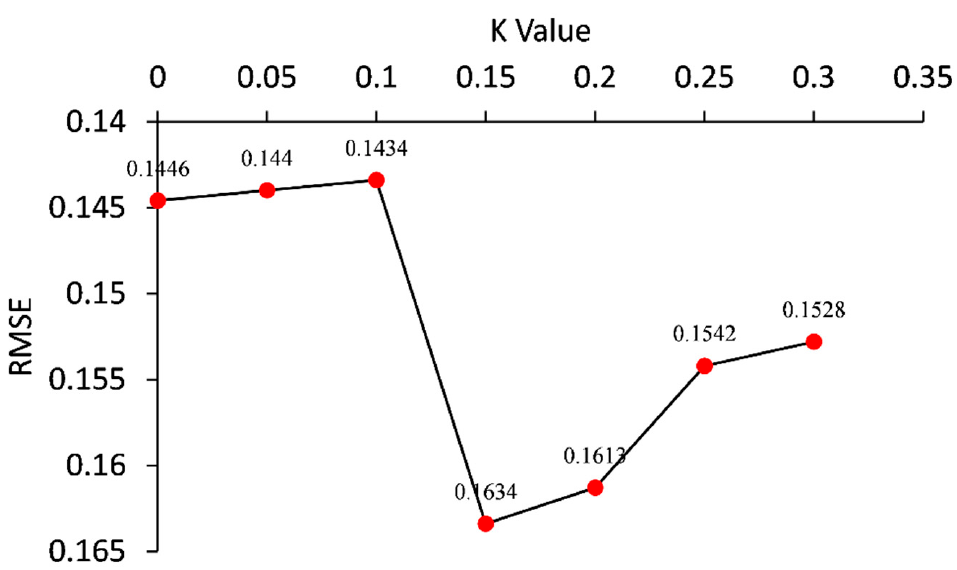
Figure 4. Curve of model accuracy variation with k value. Corresponding to different k values, the other six parameters of the BEVIs were also calculated, among which LB veg and LB soil changed with the k values, while UB veg and UB soil were fixed. When k was between 0–1, the NDVI of vegetation and soil were both stable, about 0.99 and 0.04, respectively. When k was between 0.1–0.3, the NDVI of vegetation decreased to 0.96–0.98, and the NDVI of soil increased to 0.18–0.19 (Table 2). Therefore, when k falls into the range (0, 0.1), the model parameters are most stable. Combined with the results in Figure 4, 0.1 was selected as the optimal parameter k value in this